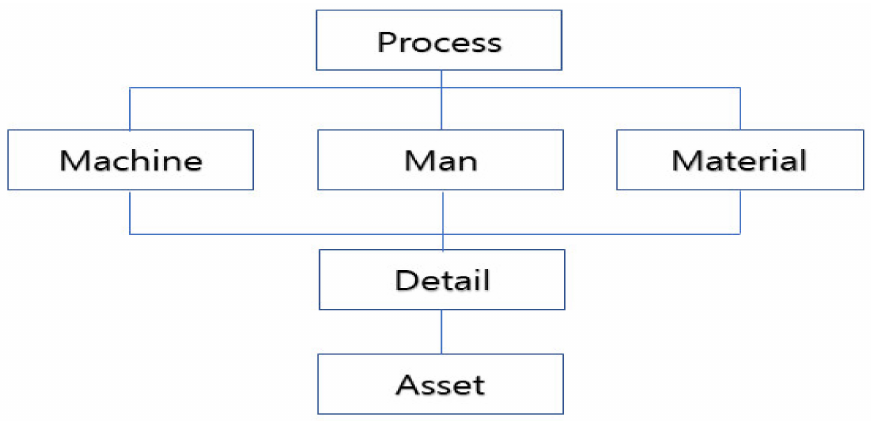
Figure 5. Semantic process major classification.